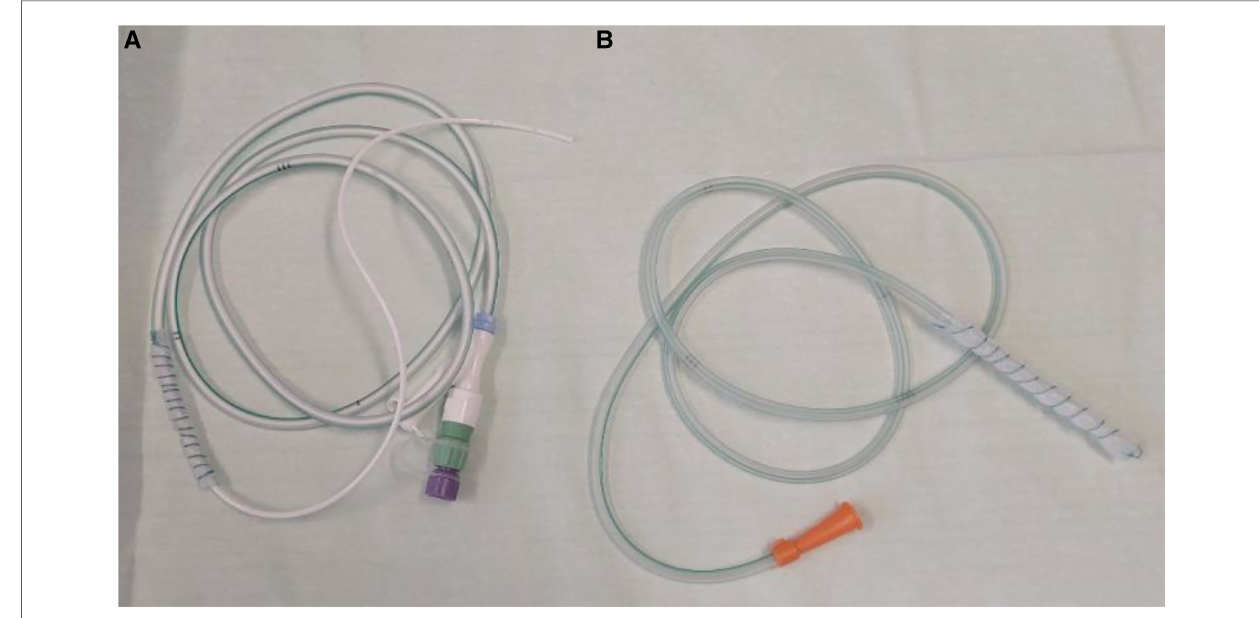
FIGURE 1 Two handmade prototype tubes for ENPT in duodenal/jejunal position. ( A ) For ENPT and enteralization: nasojejunal tube (Duodenal Tube Levin, 16 Ch, Dahlhausen, Cologne, Germany) with drainage fi lm (Suprasorb CNP, Drainage Film; Lohmann & Rauscher International GmbH & Co. KG, Rengsdorf, Germany) wrapped on the distal segment. The white intestinal tube (9Ch, out from the Freka EasyIn ® system Fresenius Kabi Deutschland GmbH, Bad Homburg, Germany). ( B ) For ENPT of insuf fi ciencies of the biliary loop: nasojejunal tube (Duodenal Tube Levin, 16 Ch, Dahlhausen, Cologne, Germany) with drainage fi lm (Suprasorb CNP, Drainage Film; Lohmann & Rauscher International GmbH & Co. KG, Rengsdorf, Germany) wrapped on the distal